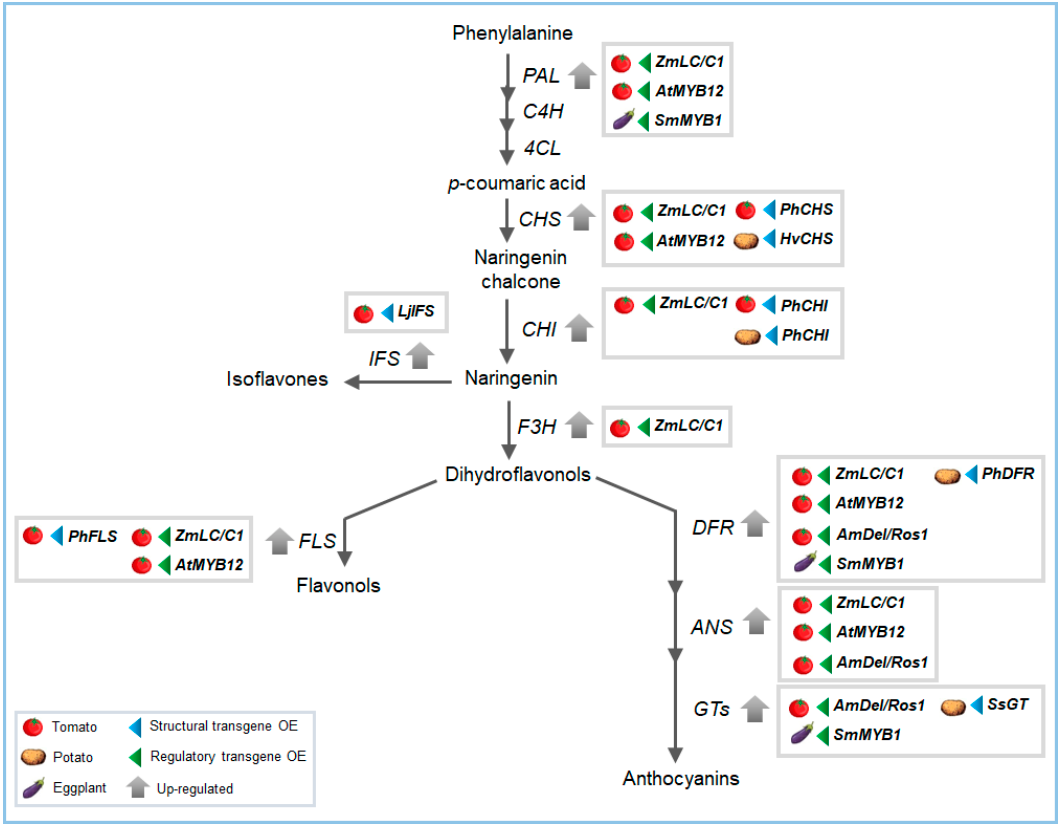
Figure 2. Flavonoid biofortification by metabolic engineering strategies through the use of structural (blue arrow on the right of the boxes) or regulatory genes’ (green arrow on the left of the boxes) over-expression (OE). The scheme reports the main genes targets studied for flavonoids improvement in horticultural species.